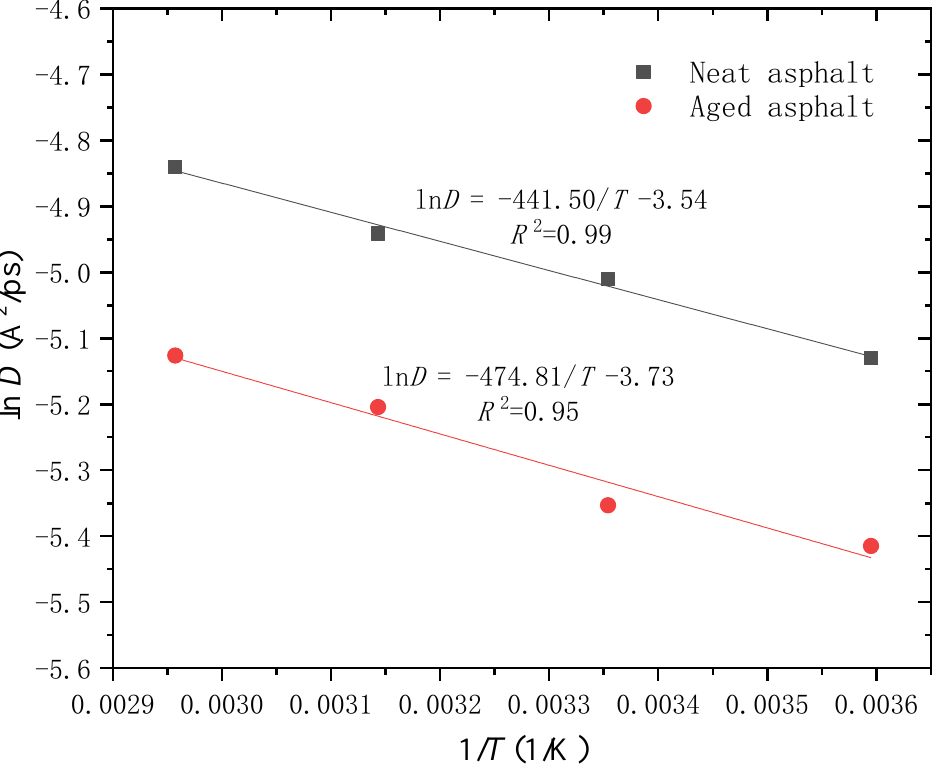
Figure 14. Relationship between ln D and 1/ T of neat and aged asphalt binder at the intrinsic healing stage.